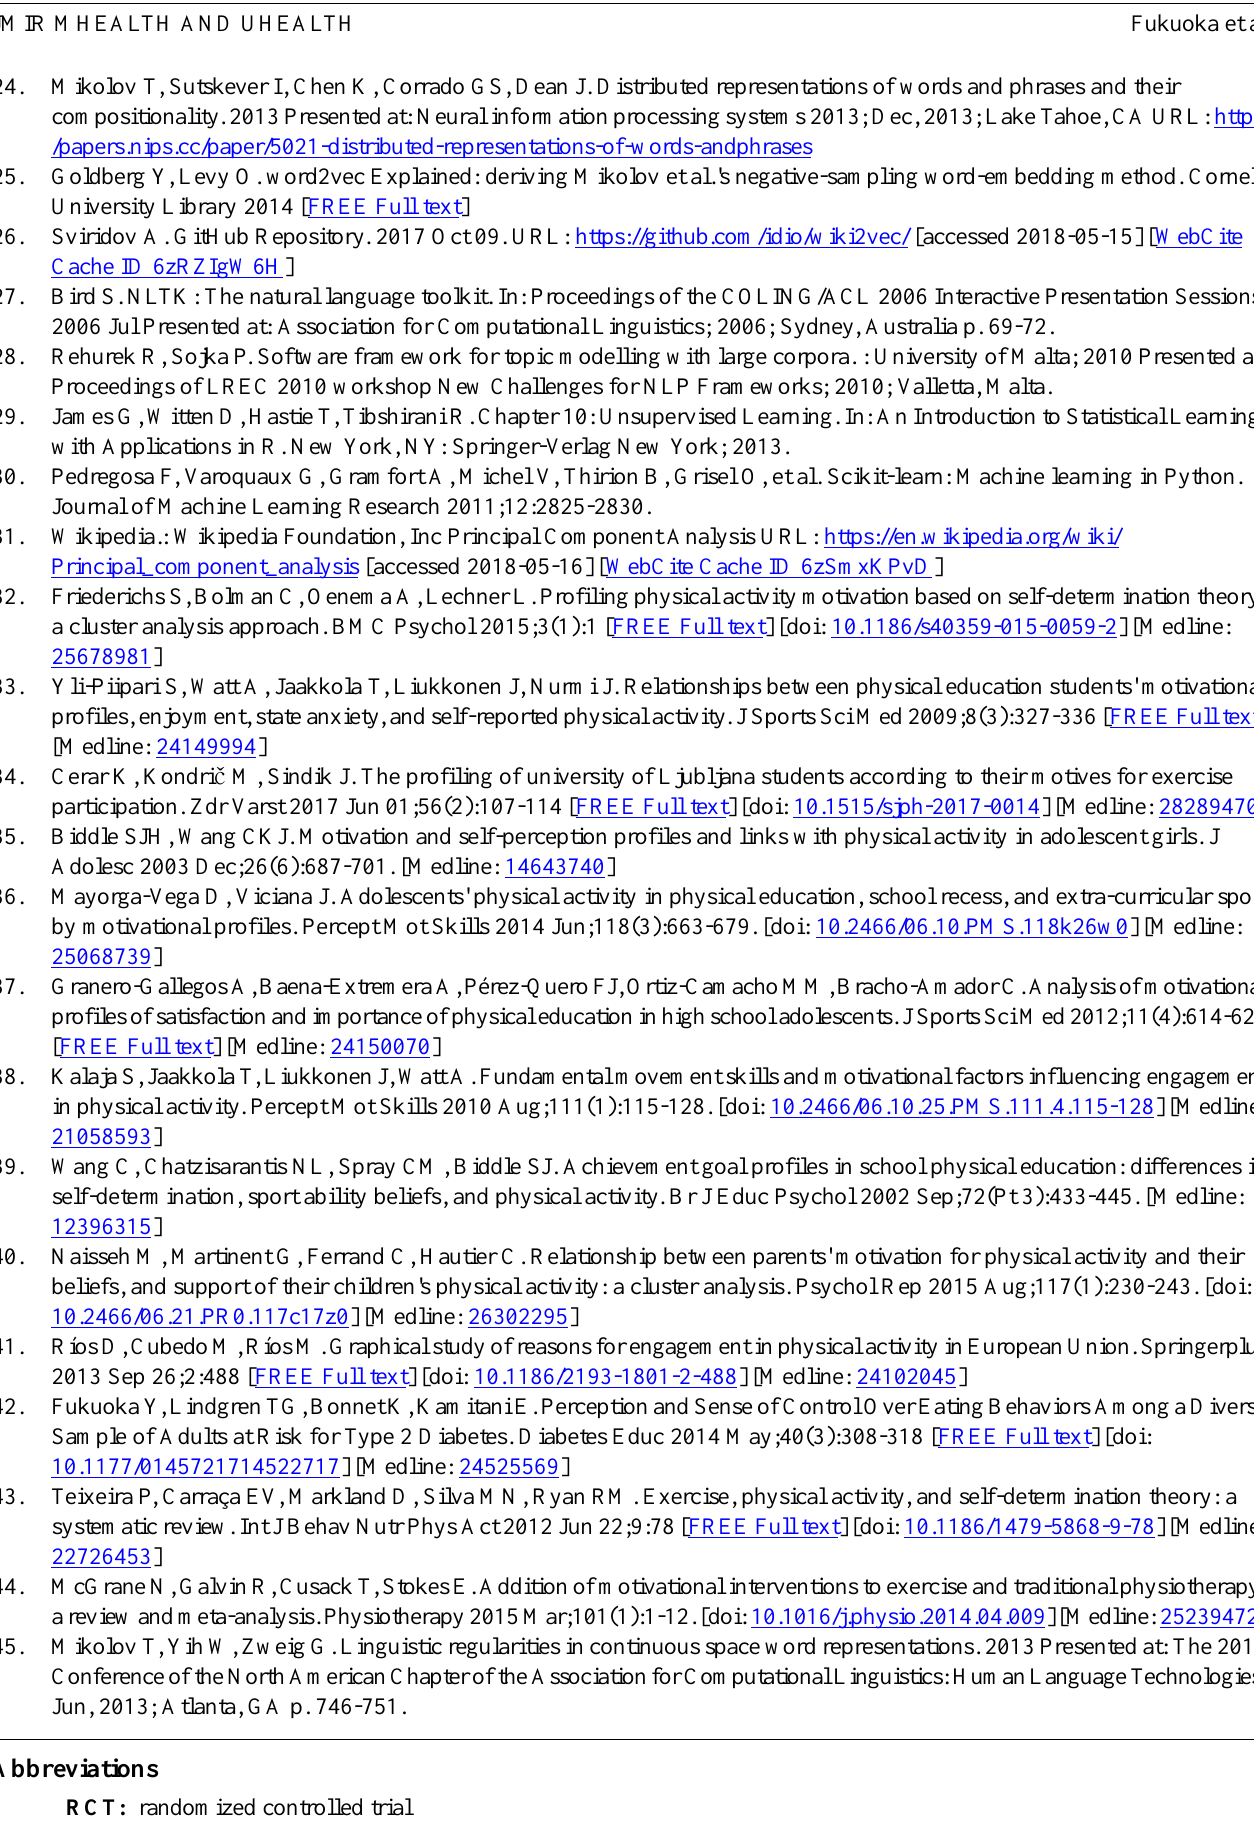
RCT: randomized controlled